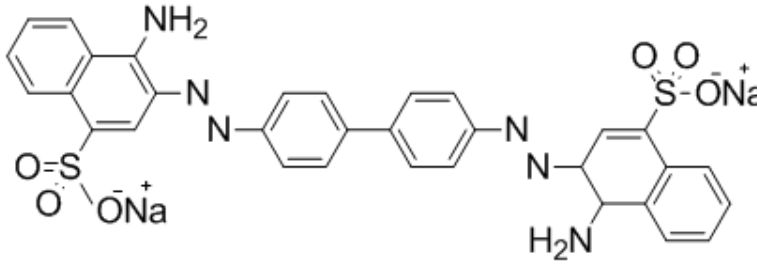
Figure 1. Structural formula of congo red (CR) dye.